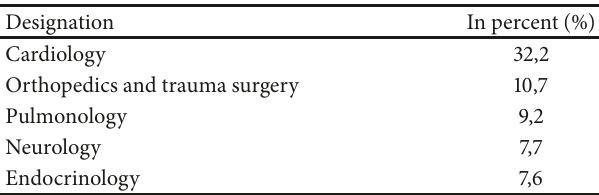
Table 3: Distribution of the most common discharge diagnoses, summarized by